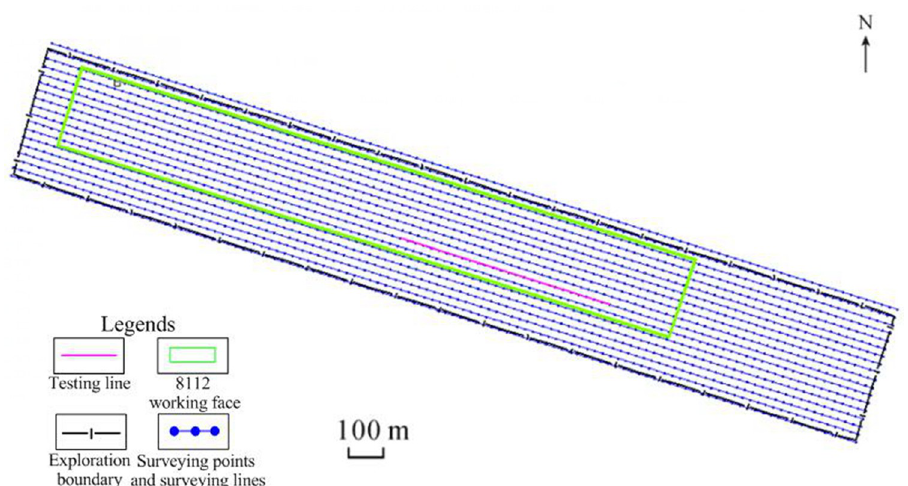
Fig 5. Diagram of the TEM workload and the testing line